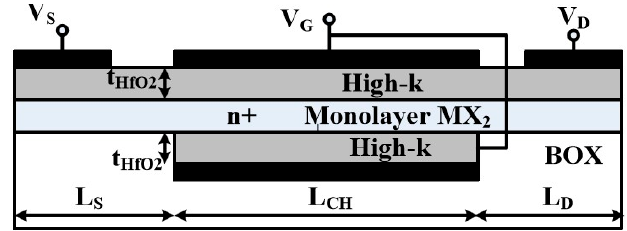
Figure 1. Schematic outlines of the double gated junctionless fi eld-e ff ect transistor (JLFET).